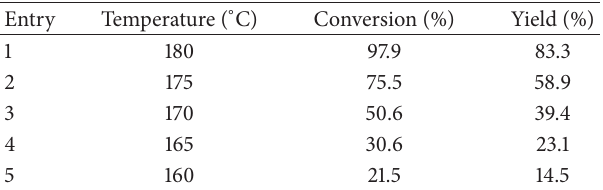
Table 1: The catalytic effect of [Bmim]ZnCl temperatures a .